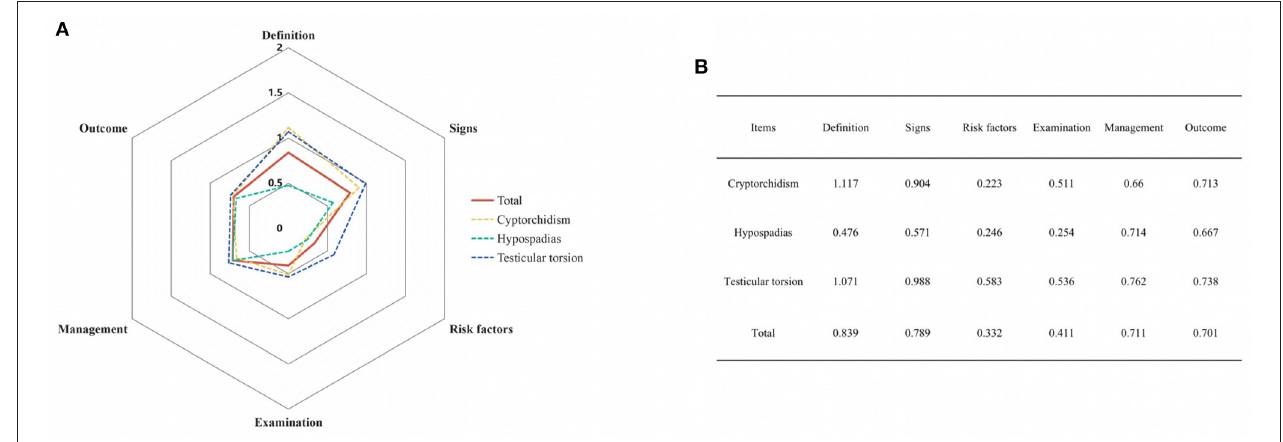
FIGURE 3 | Hexagonal radar charts of included videos. (A) Hexagonal Radar Charts of videos on cryptorchidism, hypospadias, and testicular torsion. (B) Specific results presented as